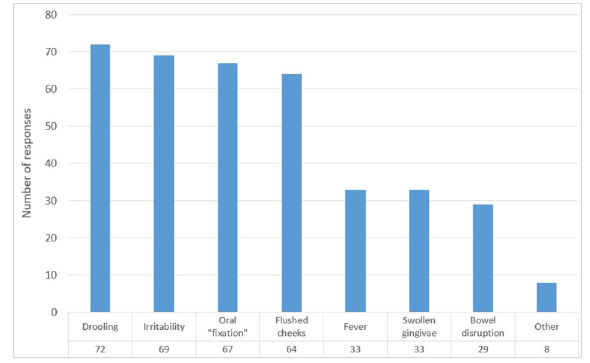
Fig. 1 Frequency of teething signs and symptoms reported by the participants ( n = 80). Participants could record more than one sign/ symptom.